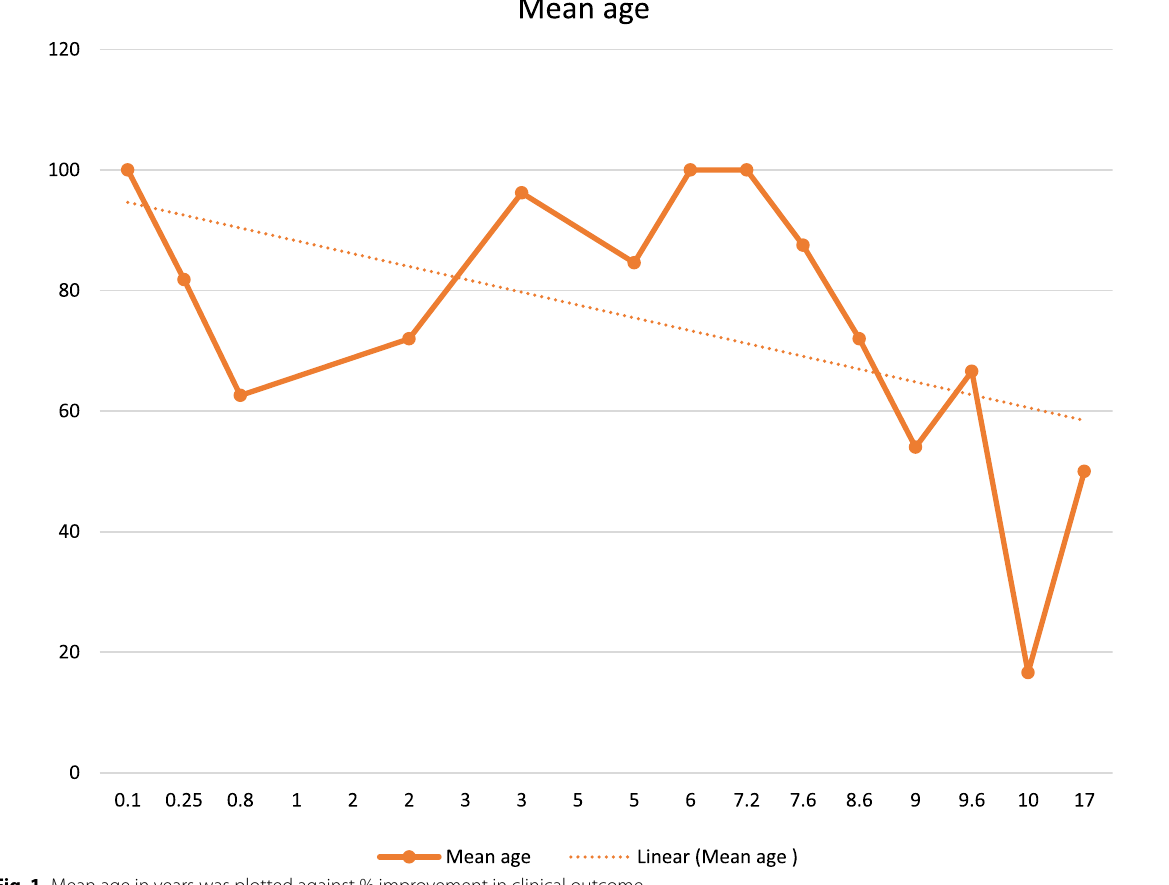
Fig. 1 Mean age in years was plotted against % improvement in clinical